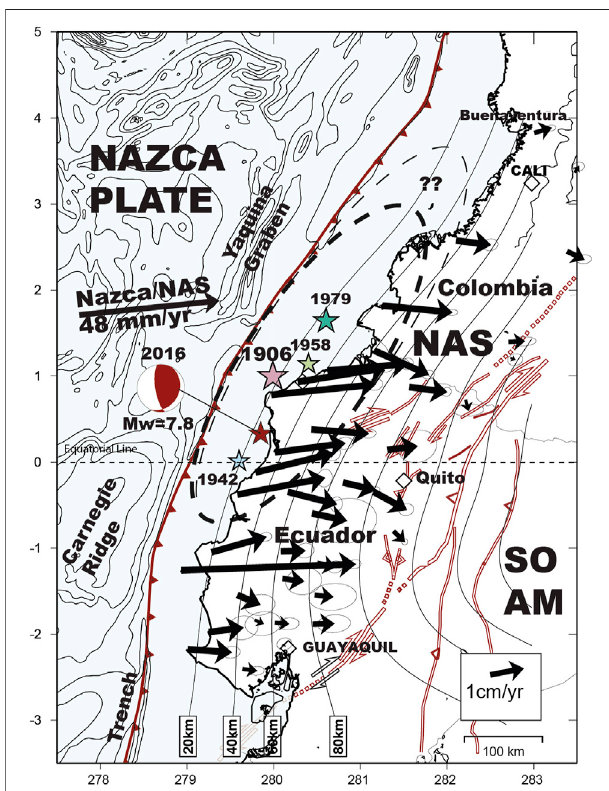
FIGURE 2 | GPS velocities (black arrows) in the North Andean Sliver reference frame from Mora-Paez et al. (2019) with their respective error ellipses. The relative Nazca/NAS convergence rate taken up by the subduction interface is about 48 mm/yr at the Colombia – Ecuador border. Interseismic GPS velocities pointing towards the east show variable decreasinggradientswhichattestforvariationsonthefrictionalcouplingalong the megathrust interface. The epicenter location (red star) and focal mechanism (from the Harvard gCMT catalog) associated with the 2016 Mw (cid:1) 7.8 Pedernales earthquake are consistent with a subduction earthquake that occurred on the megathrust interface. The megathrust geometry is reported from Slab 2 model geometry (Hayes et al., 2018) with iso-depth contours every 20 km.